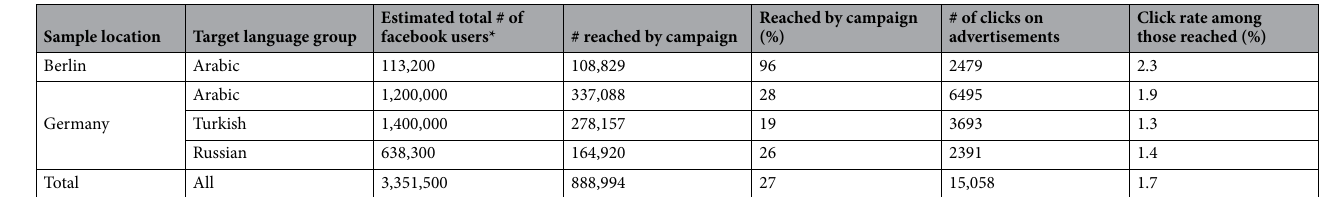
Table 1. Online campaign reach relative to Facebook population in November and December 2021. Note: Data collected by the authors. *As of November 2021.